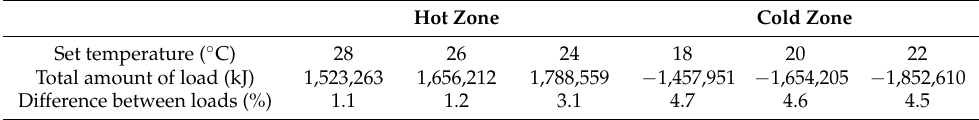
Table 8. Zone thermal load according to set point